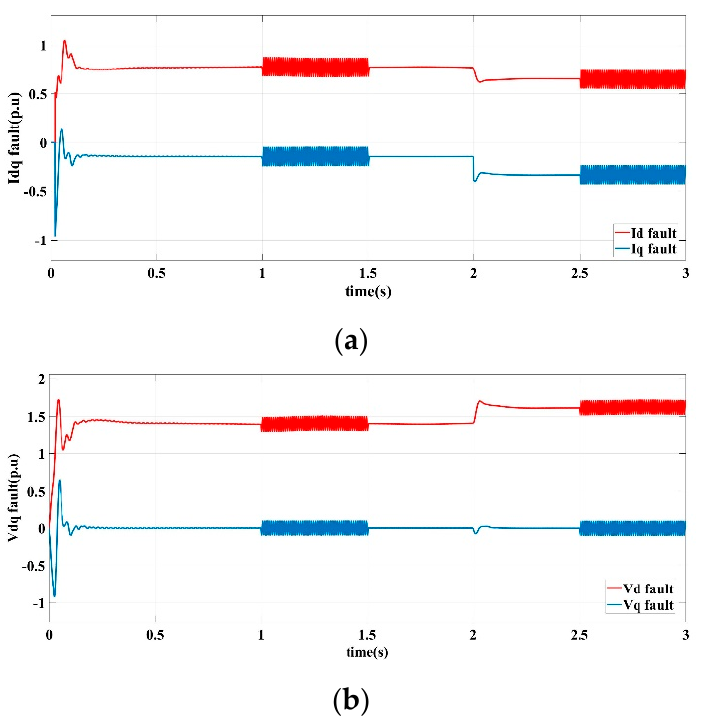
Figure 6. Output feedback control response curves in Scenario II, ( a ) d -axis and q -axis current output, ( b ) d -axis and q -axis voltage output.